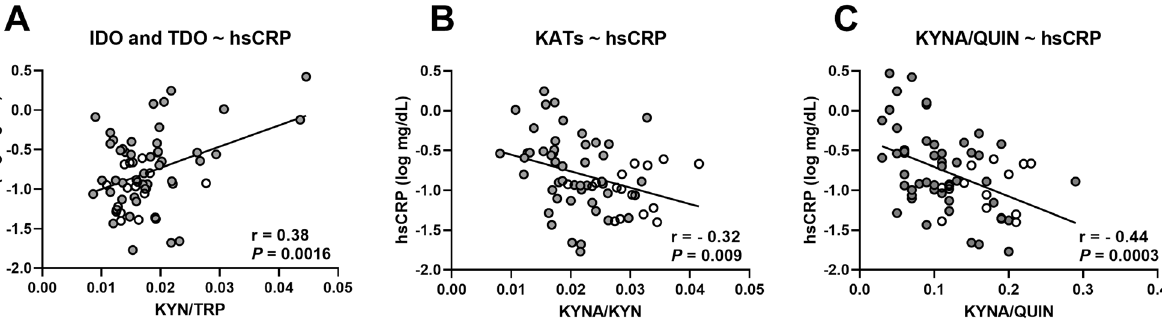
Fig. 2 Correlations between the in fl ammatory markers and the metabolic ratios. Correlations between the plasma level of in fl ammatory markers hsCRP and the metabolic ratio re fl ecting ( A ) the sum of IDO and TDO activities, ( B ) KATs activity and ( C ) the balance between neuroprotective and neurotoxic metabolites. The correlations were calculated in healthy controls (white circles) and in AUD patients (gray circles) at the end of the detoxi fi cation program (T2) using Pearson ’ r coef fi cient, n =